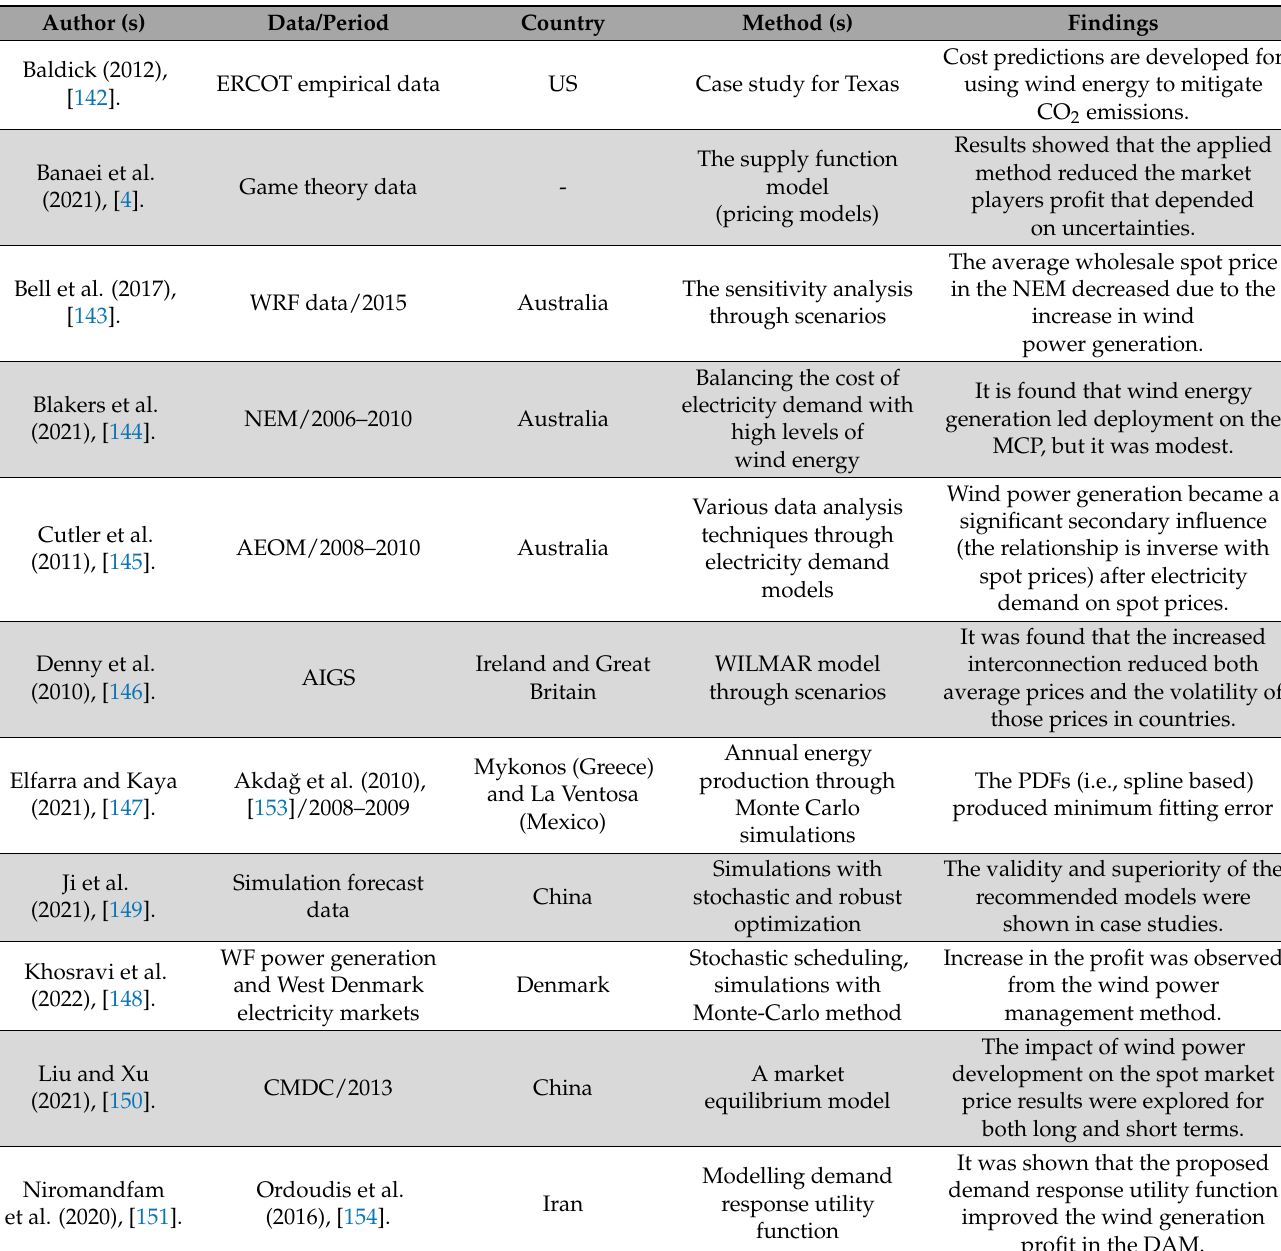
Table 5. A literature review through middle/long term models on electricity market price and load forecasting through wind